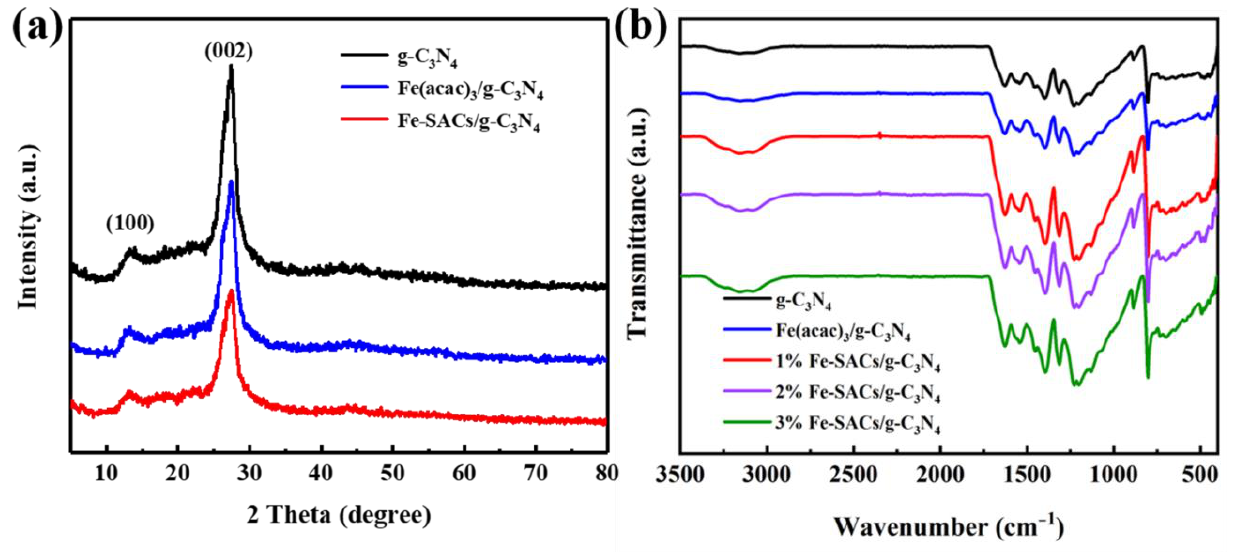
Figure 2. XRD patterns of gC 3 N 4 , Fe(acac) 3 /gC 3 N 4, and FeSACs/gC 3 N 4 ( a ); FTIR spectra of gC 3 N 4 , Fe(acac) 3 /gC 3 N 4, and FeSACs/gC 3 N 4 ( b ).